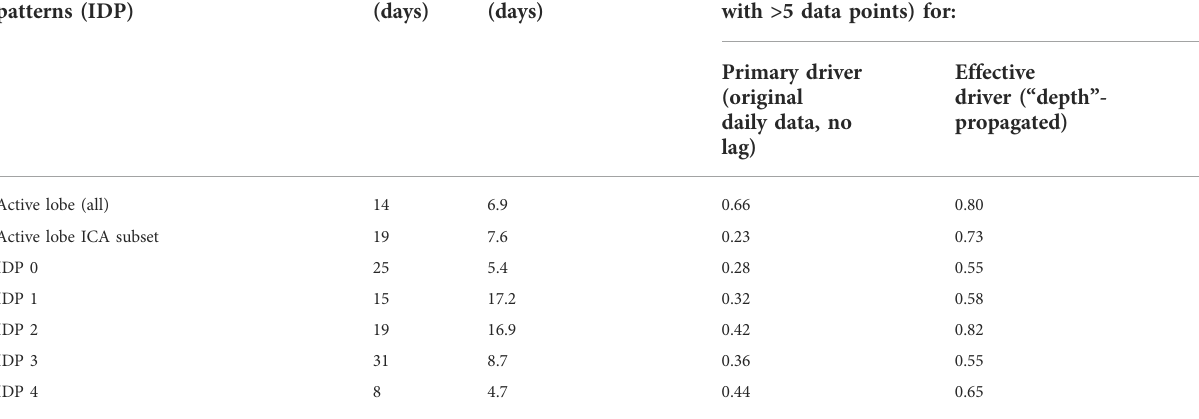
TABLE 2 Gaussian parameters for “ active lobe ” displacement gradient and IDP intensities for the effective (propagated). Independent deformation patterns